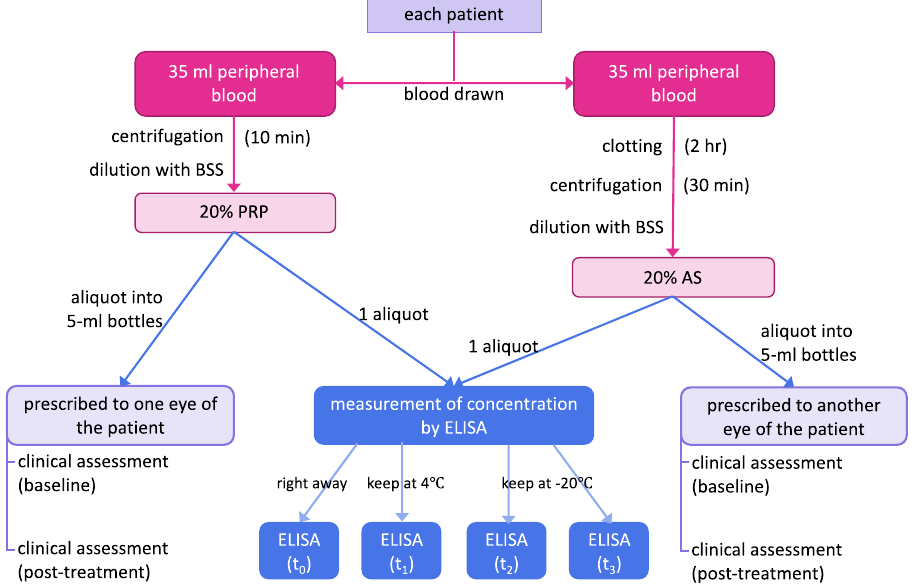
Figure 1. A summary of the design of the study. The diagram shows the process done for each patient; these processes were performed for all 10 patients in parallel. PRP platelet-rich plasma, AS autologous serum, ELISA enzyme-linked immunosorbent assay. The details of the methods are stated in the “Methods” section.